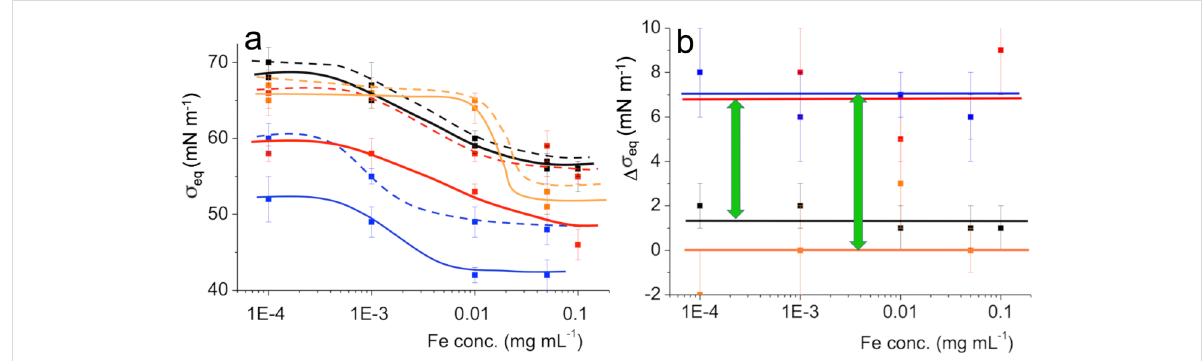
Figure 4: a) Variation of the interfacial tension at equilibrium ( σ eq , 25 °C) as a function of the Fe concentration in dispersions of IONPs grafted with dendrons (C 2 H 5 OEG 8 Den: black; C 2 F 5 OEG 8 Den: red; C 4 H 9 OEG 8 Den: orange and C 4 F 9 OEG 8 Den: blue) at the air (dashed line) and F -hexane-satu- rated air (solid line)/aqueous phase interface. b) Variation of the difference of the interfacial tension at equilibrium ( Δσ eq ) measured under air and under F -hexane-saturated air versus Fe concentration for various IONPs (same color code). The green arrows highlight the difference in behavior be- tween fluorinated and non-fluorinated dendrons.